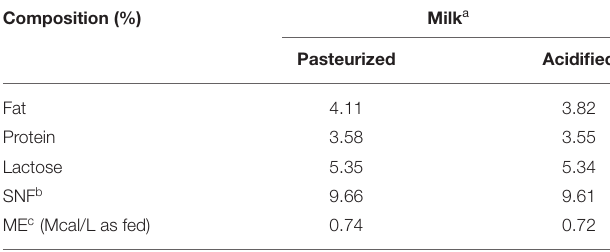
TABLE 1 | Chemical composition of pasteurized and acidified milk.